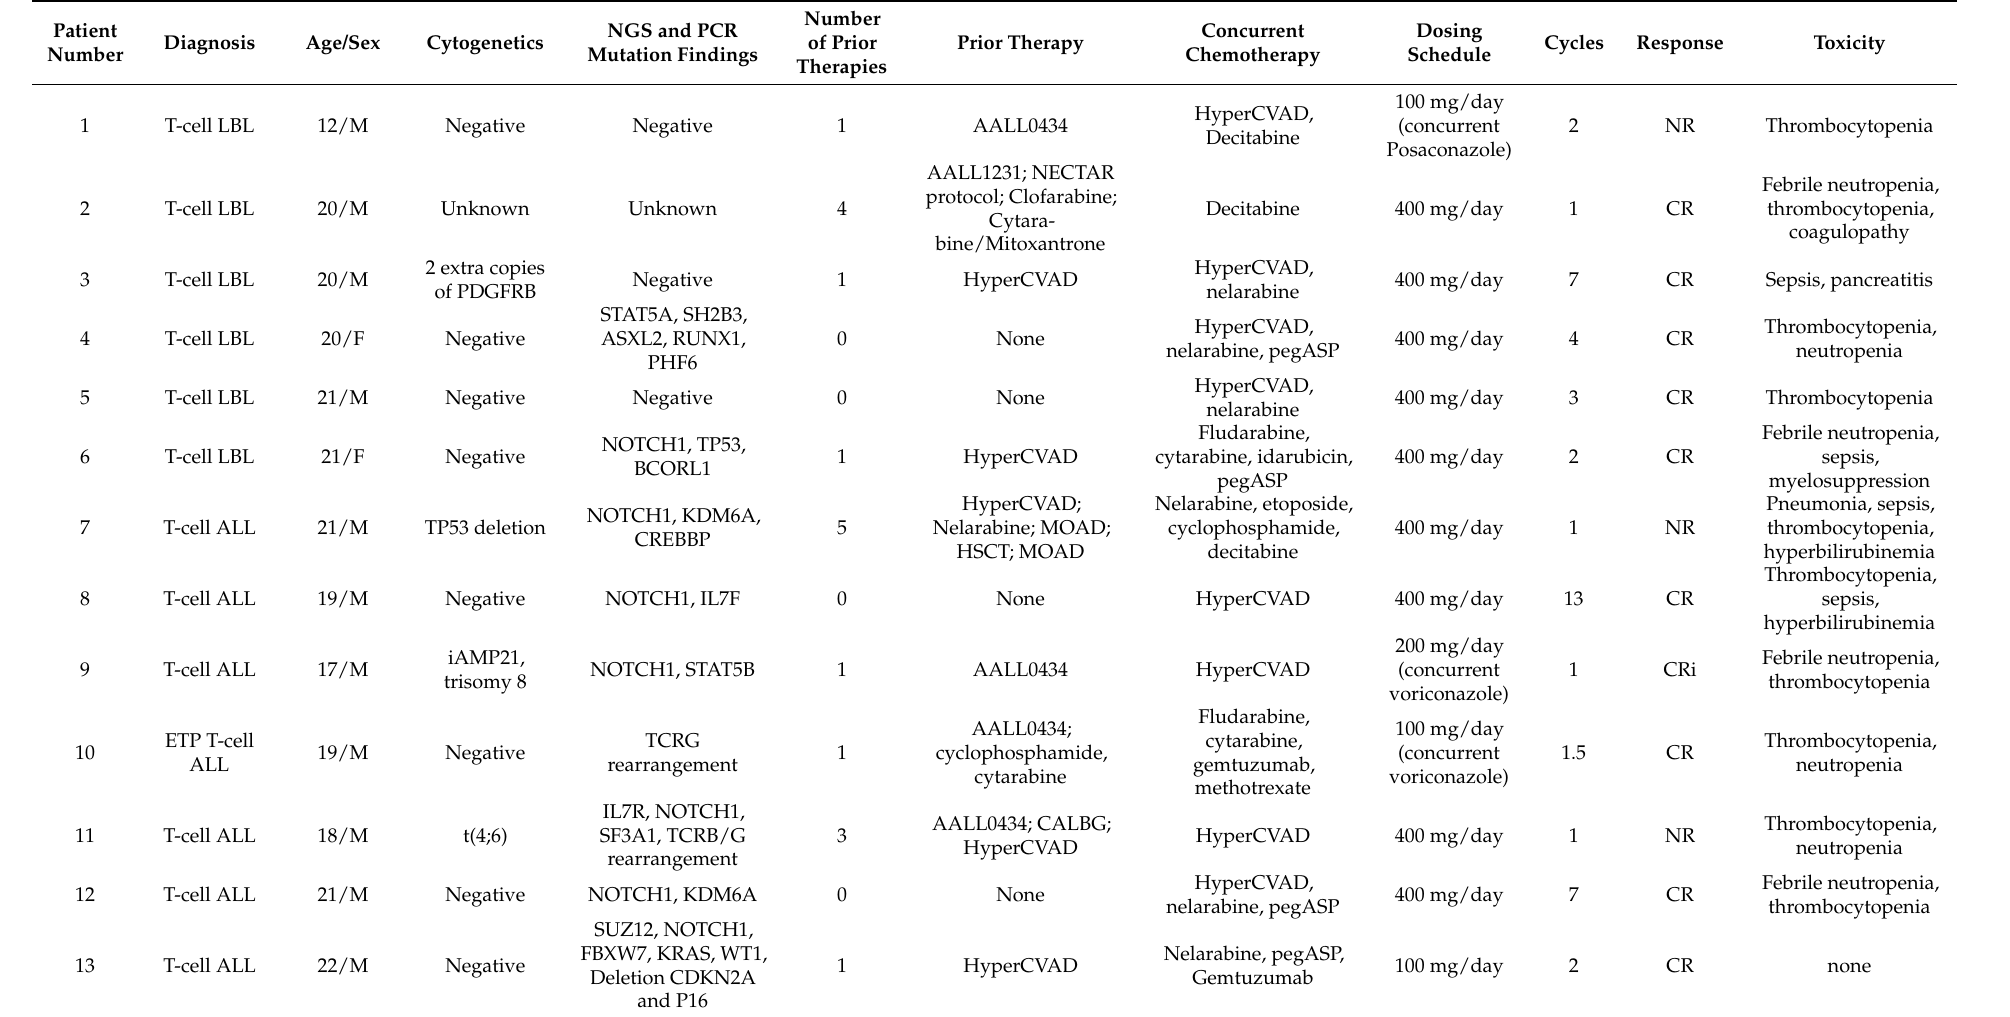
Table 2. Patient disease characteristics, concurrent therapy, dosing schedule for venetoclax, number of cycles given, response and